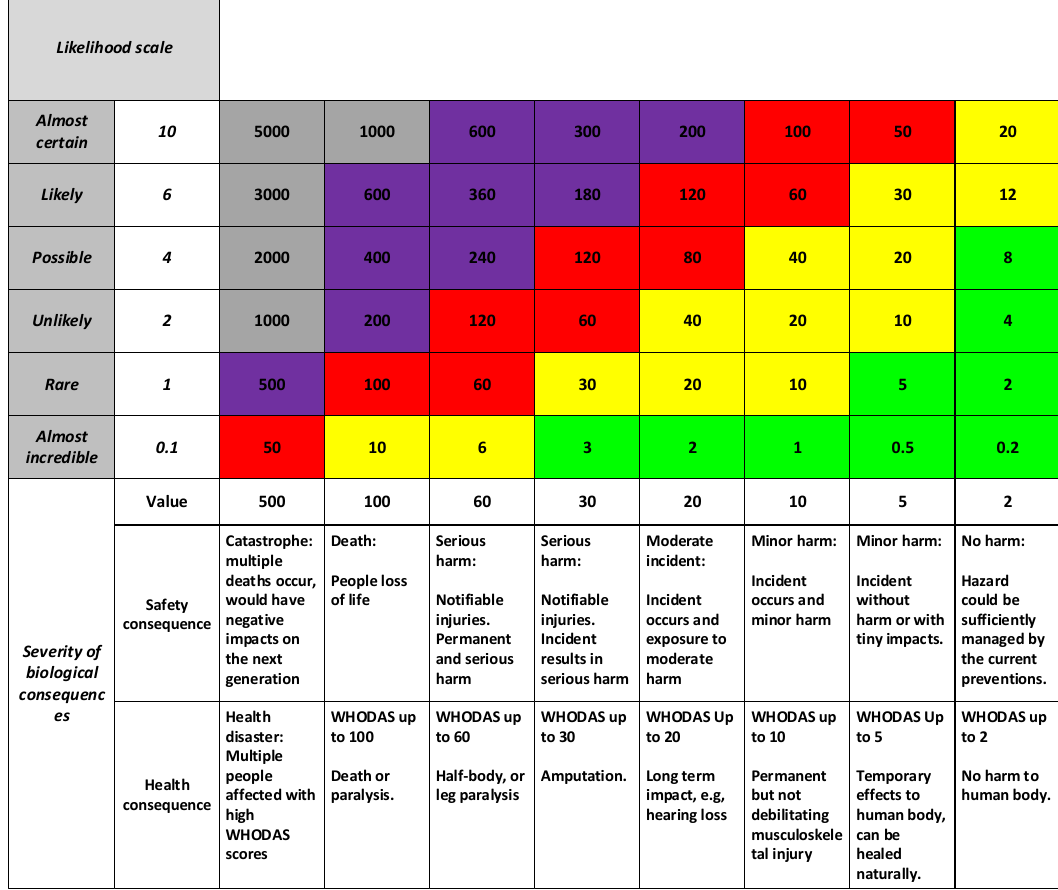
Figure 7. Risk matrix with harmonized consequence scale for safety and health outcomes, and the new likelihood scale.